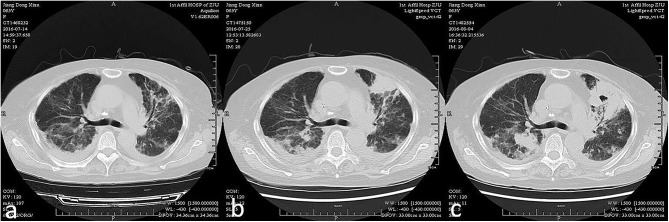
Acute exacerbation of interstitial lung disease of a patient within 3 weeks (from a–c chronologically).